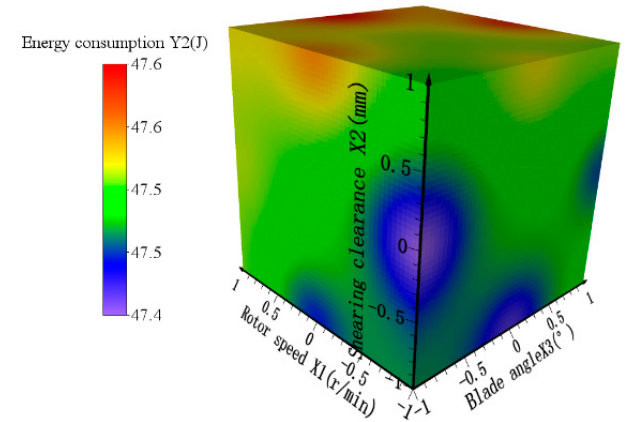
Figure 15. Four-dimensional rendering graph illustrating the influence of the cutter shaft speed, cutting clearance, and cutter edge angle on the energy consumption of straw